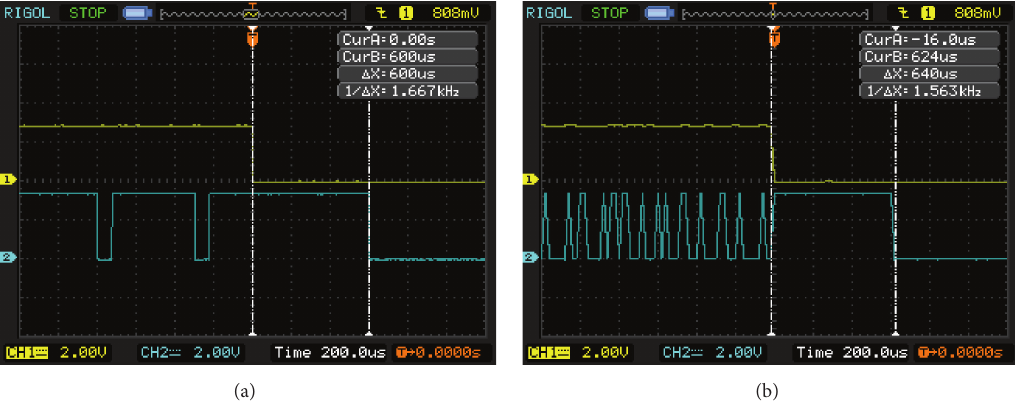
Figure 9: Oscilloscope screenshots of automatic protection. (a) CH1: failure alarm signal and CH2: first closed SM1 signal. (b) CH1: failure alarm and CH2: last closed PWM signal (2V/div, 200 us/div).